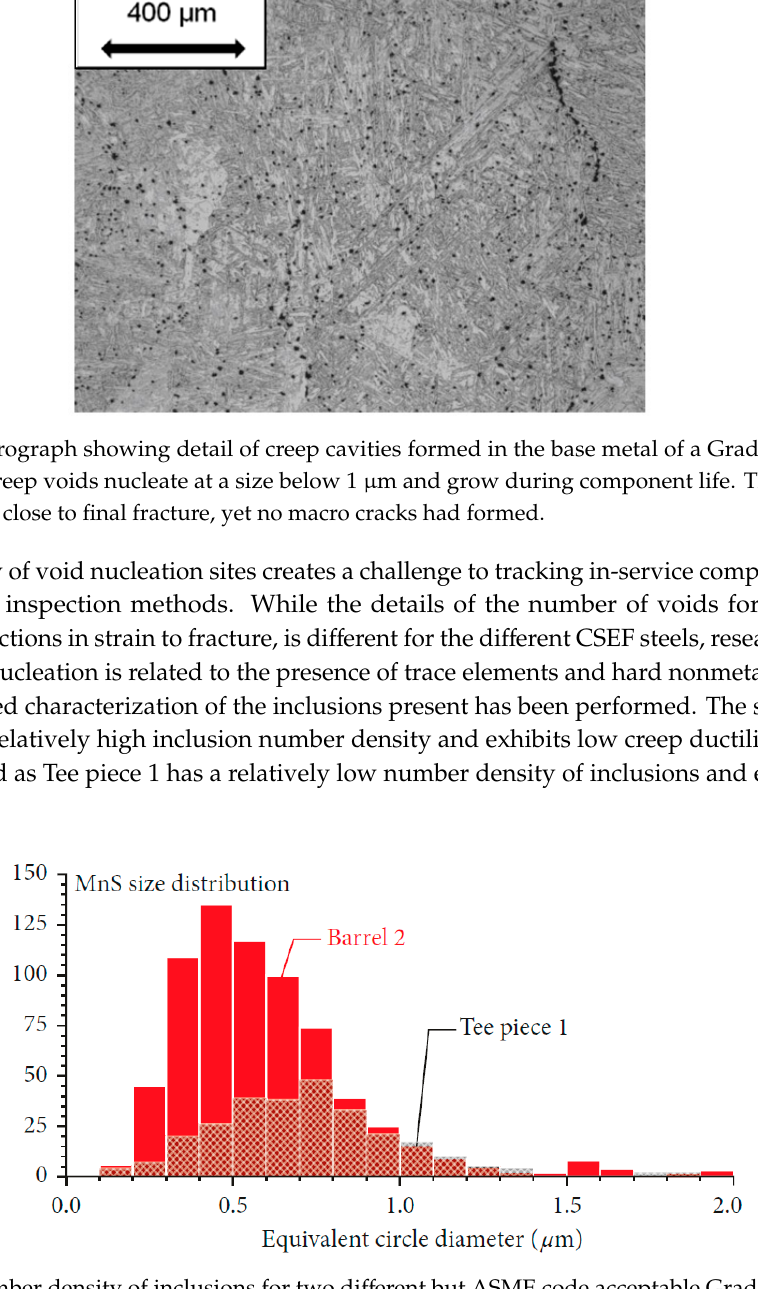
Figure 3. Number density of inclusions for two different but ASME code acceptable Grade 91 steels. A higher density of MnS was measured in the creep damage susceptible steel which contained 0.009 wt.% S (labelled barrel 2) as compared to the cavity resistant steel which contained 0.002 wt.% S (labelled tee piece 1).